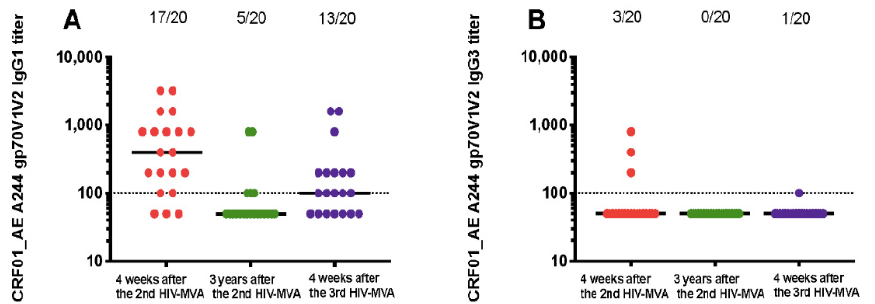
Figure 3. IgG subclass responses to gp70V1V2 protein of CRF01_AE A244. Vaccine-induced IgG1 ( A ) and IgG3 ( B ) binding responses to CRF01_AE A244 V1V2 antigen. Antibody responses at four weeks